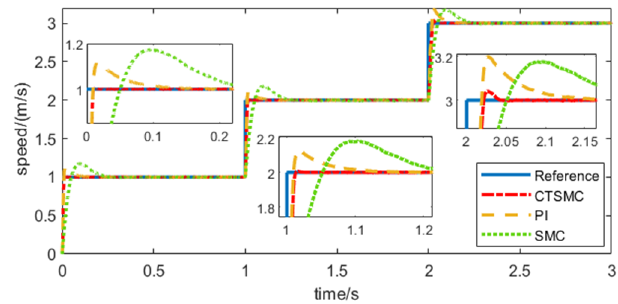
Figure 4. Speed comparison. Figure 4. Speed